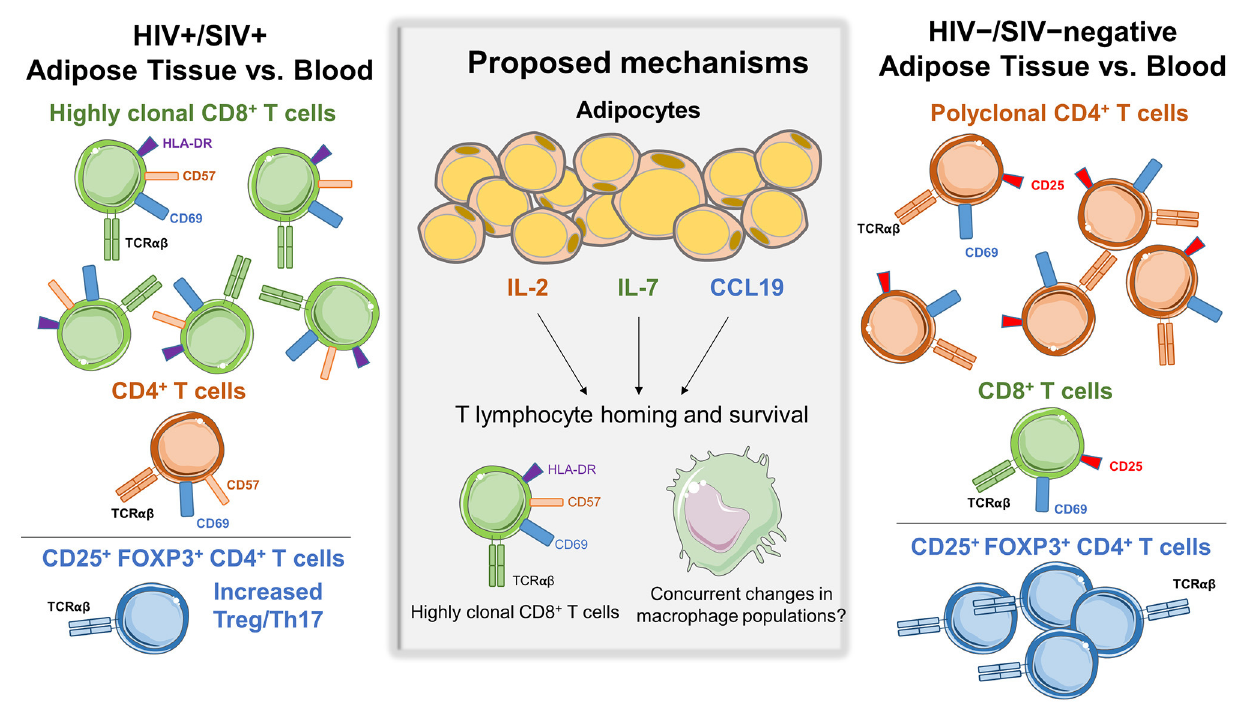
FIGURE 1 | Differences in adipose tissue and blood CD4 + and CD8 + subsets in HIV/SIV + vs. HIV/SIV-negative subjects. Adipose tissue in HIV/SIV + subjects is enriched in CD8 + T cells compared to blood, while HIV/SIV-negative adipose tissue is enriched in CD4 + T cells. A proposed mechanism is the preferential recruitment of cells from circulatory/lymphatic systems via differences in cytokine expression by adipocytes and adipose tissue stromal vascular fraction cells in HIV/SIV + including IL-2, IL-6, IL-7, IL-8, CCL19, IL-12p40, and MIP-1 α , eotaxin and interferon gamma. While a study in HIV + subjects found increased CD8 + T cell clonality in adipose tissue, there is currently not compelling evidence of in situ CD4 + or CD8 + T cell proliferation within adipose